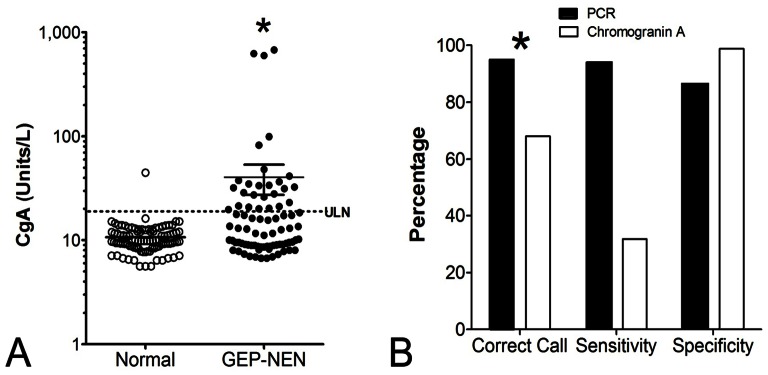
Comparison of the 51 marker gene signature with Chromogranin A (CgA) for detecting GEP-NENs.
A) CgA levels were significantly elevated in the GEP-NEN group (n = 176; *p<0.002) but an overlap with normal values was identified. B) Comparison of the PCR-based approach with CgA protein measurement identified that call rates were significantly higher for the PCR-based test (*p<0.0005, χ2 = 12.3). The PCR blood test was significantly more accurate than measurement of CgA levels to detect GEP-NENs. ULN = upper limit of normal (19U/L – DAKO).